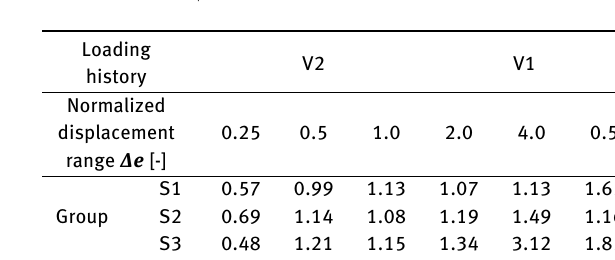
Table 6: Deterioration of flexibility ξ ( ∆e ) for V1, V2 loading histories at the load factor 𝛾 1 =